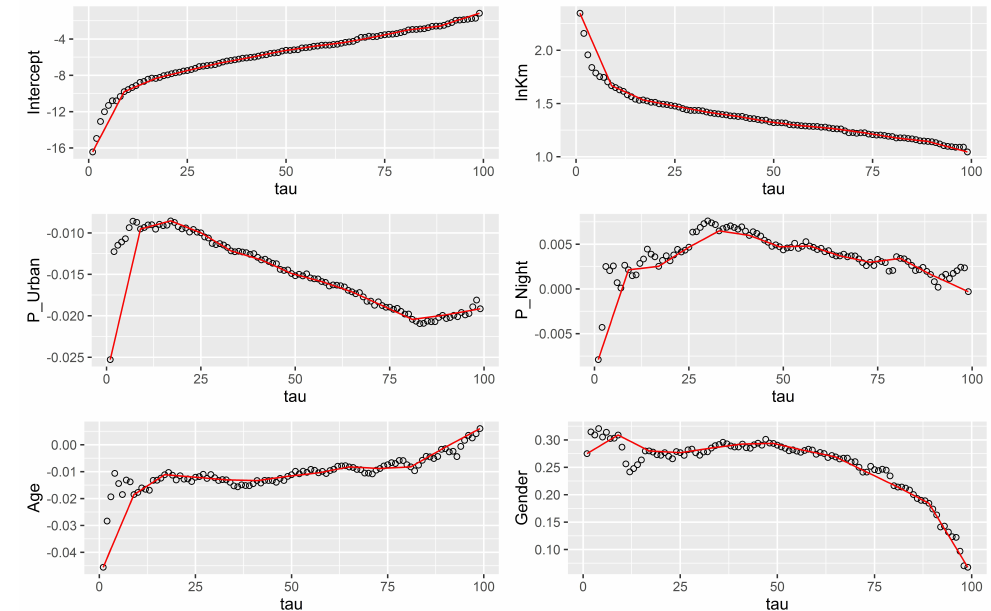
Figure 4. Estimates of β τ for different quantile levels. Dots indicate the parameter estimates when adjusting 99 quantile regressions, lines denote the approximations obtained for m = 13 initial quantile regressions with equally spaced τ